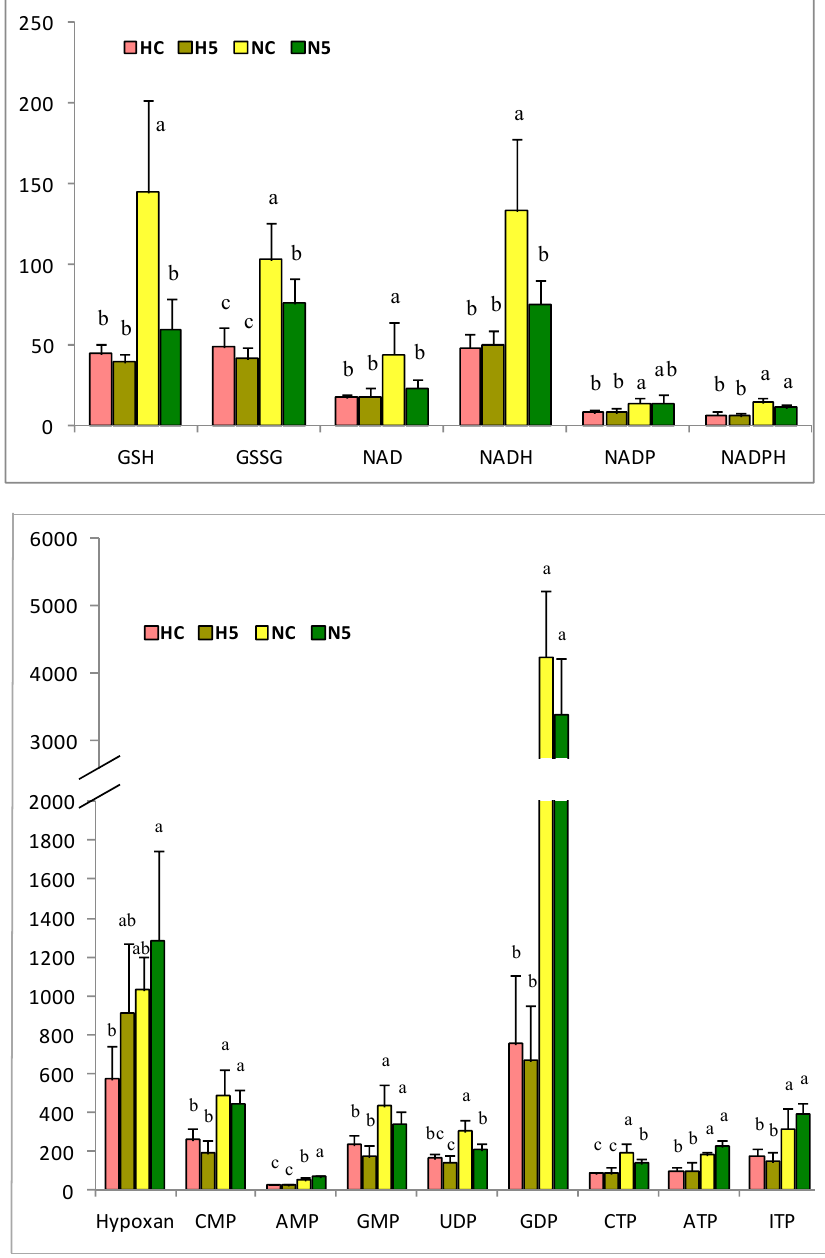
Figure 6. Antioxidant and nucleotide compounds in the liver of rats of the four experimental groups (HC: high fat diet, H5: high fat diet + 5% spinach, NC: standard diet and N5: standard diet + 5% spinach). The bar height indicates the mean value of each feed condition and the error bar indicates the standard deviation. a–c Different letters indicate significant statistical differences ( p < 0.05). GSH: